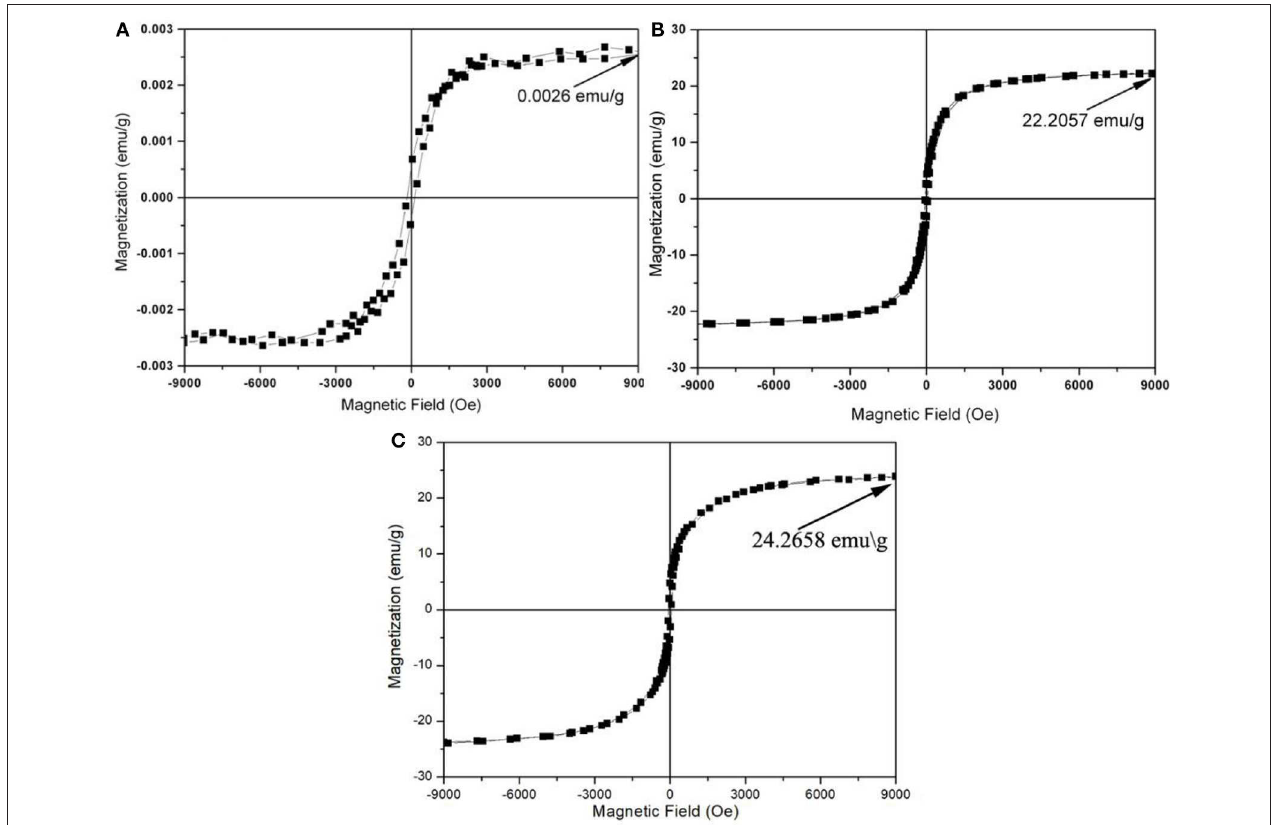
FIGURE 2 | Hysteresis loops of samples: (A) CCF, (B) CNCF1, and (C) CNCF2 composites.